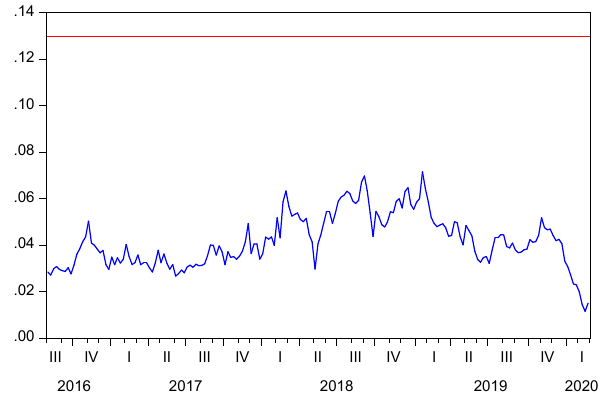
Figure 7. Nord Pool system price and the fixed electricity price of 0.13